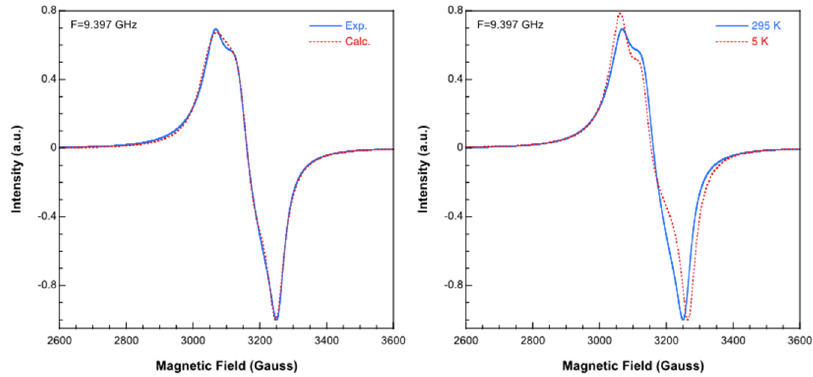
Figure 6. X-band ESR spectra of compound 1 . See text for the fitting parameters.